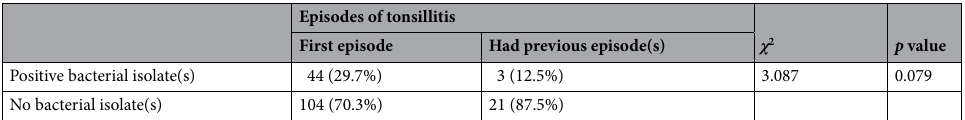
Table 4. Comparative analysis of the isolates between the 1st episodes and those with previous